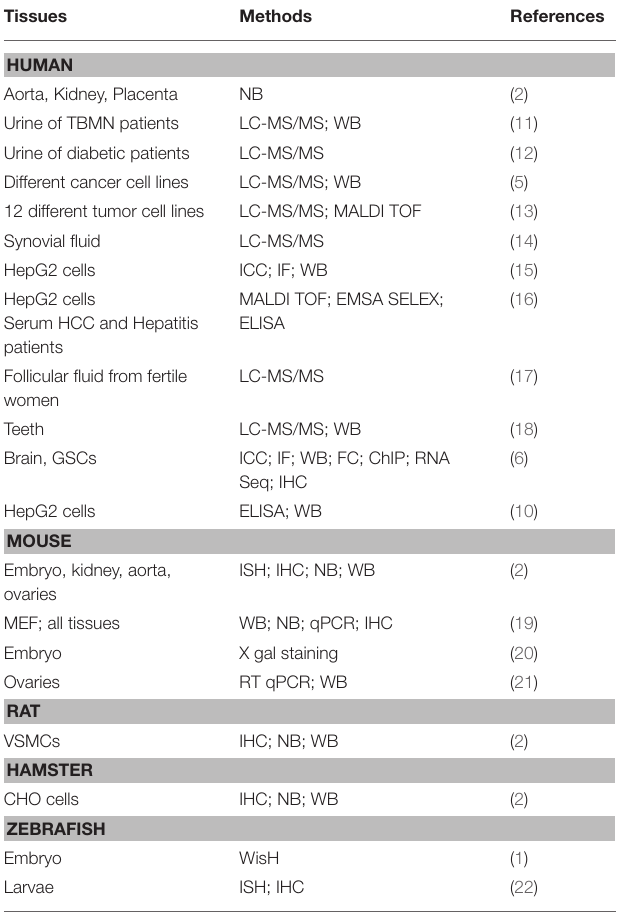
TABLE 1 | Vasorin expression and methods of